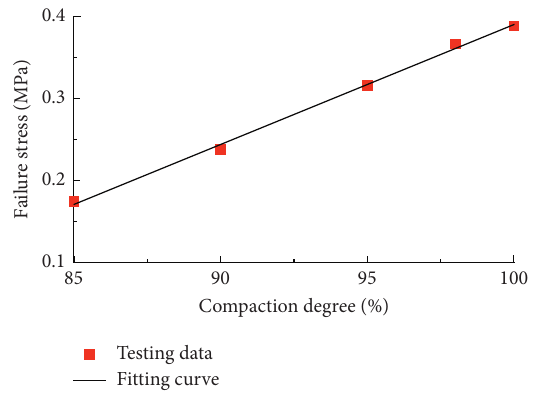
Figure 3: The relationship between compaction degree and failure stress (confining pressure � 0.1MPa; water content � 8.5%).